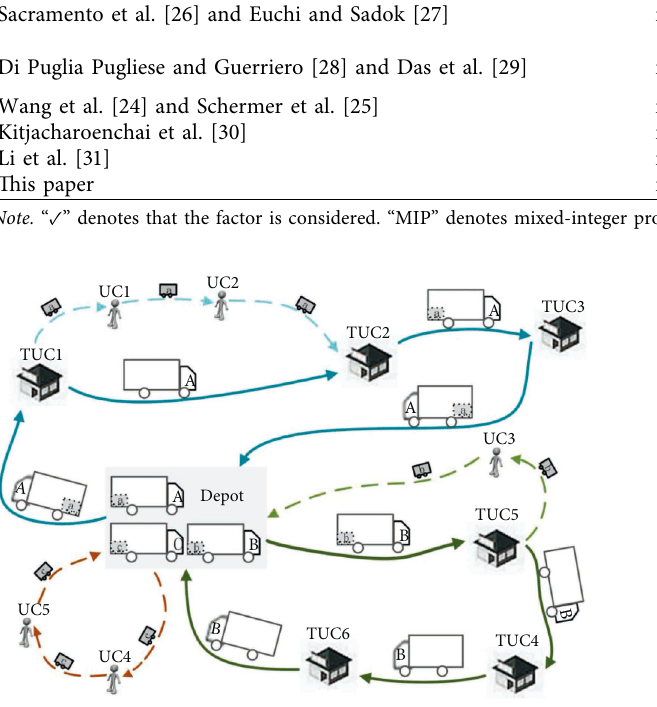
Figure 2: Route examples of the TUVRP-TW.